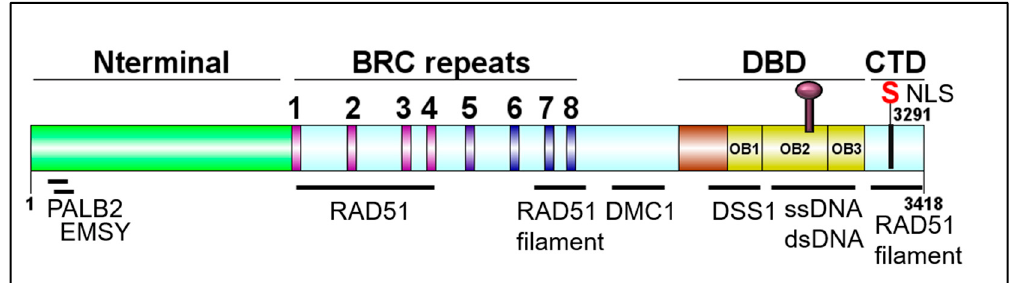
Figure 2. Schematic of BRCA2 domains. DBD: DNA binding domain; CTD: C-terminal domain. DOG illustrator of protein domain structure [50].